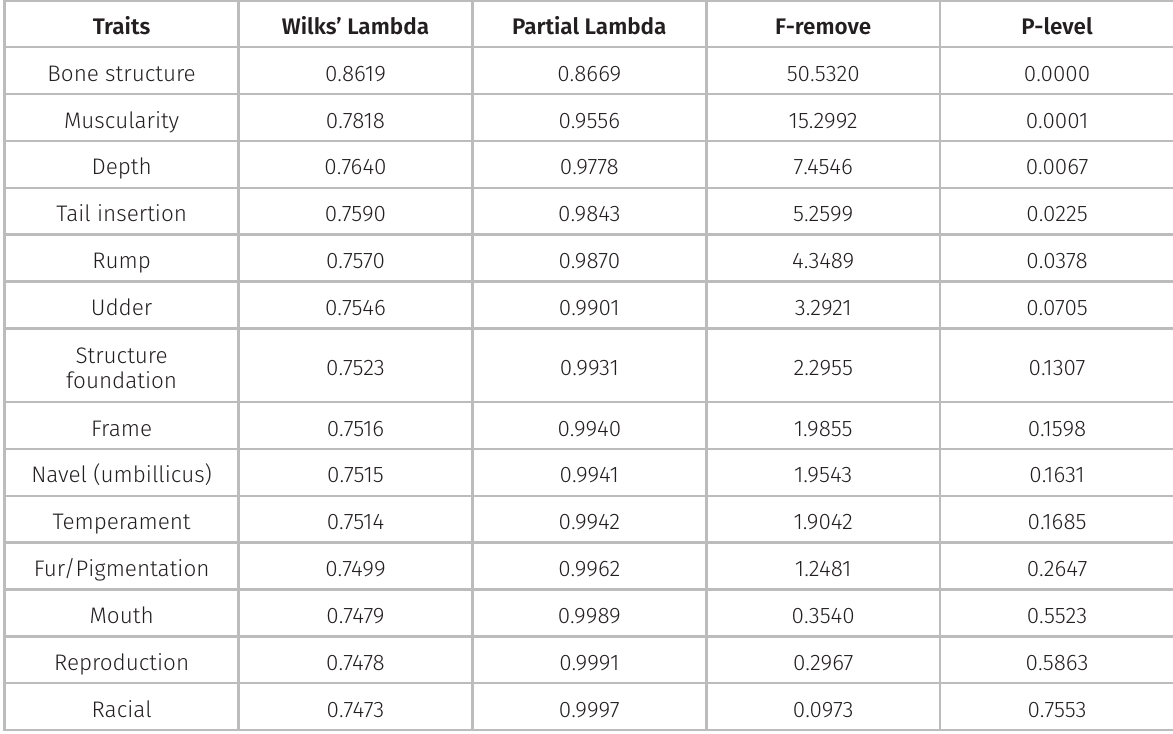
Table V. Discriminant analysis between visual scores traits with early pregnancy heifer diagnostic. Traits